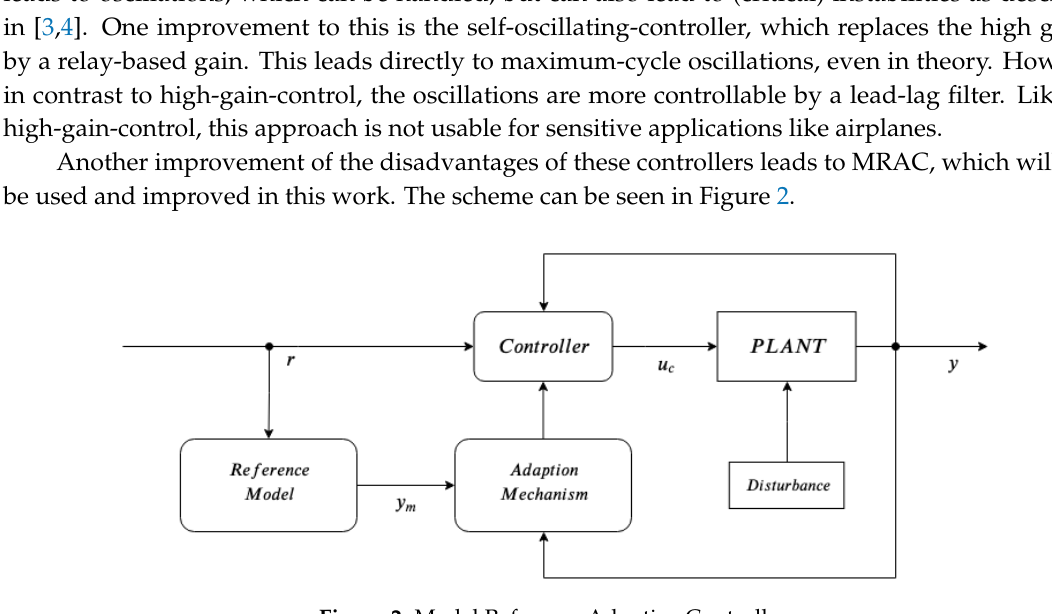
Figure 2. Model Reference Adaptive